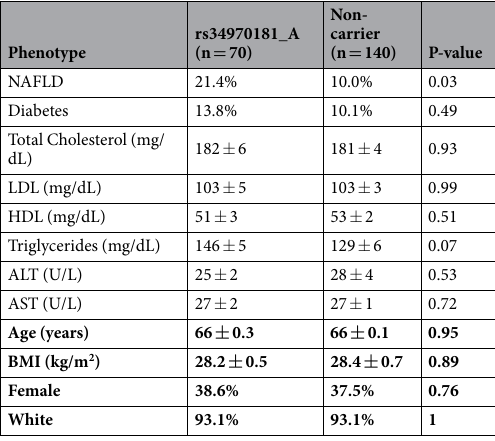
Table 2. The human ALK6 variant rs34970181_A was associated with NAFLD in a retrospective cohort study. Data from human carriers of rs34970181_A and matched non-carriers are presented. Matched characteristics are shown in the bottom section including age, BMI, sex, and race. Unmatched characteristics are shown in the top section. NAFLD status was determined by blinded physician chart review. Diabetes status was determined by ICD coding of the disease. Reported lab values are means of lifetime median values. Comparisons were performed using Fisher’s exact test for categorical data and Student’s t test for continuous variables. Mean ± SEM for continuous variables Abbreviations: Low-density lipoprotein (LDL); High-density lipoprotein (HDL); alanine aminotransferase (ALT); aspartate aminotransferase